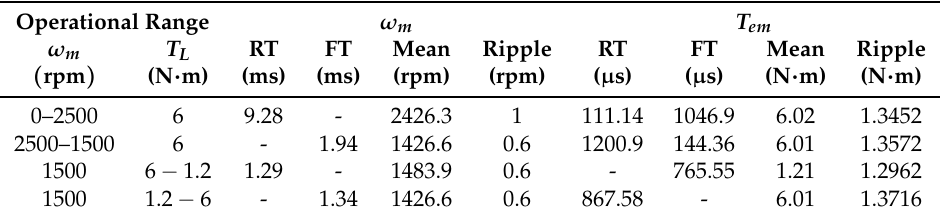
Figure 8. PI control loop, series configuration. Speed and torque plots. Table 5. PI control loop, cascaded configuration. Transient and steady state